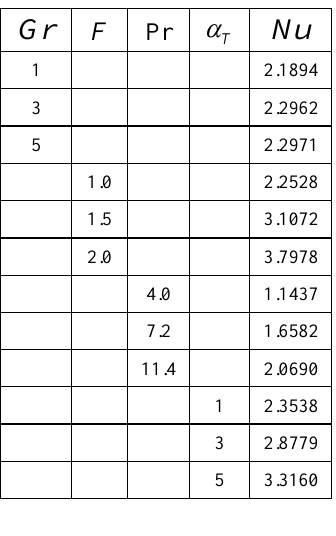
Table 2. Effect of various physical parameters on Nusselt number () N u